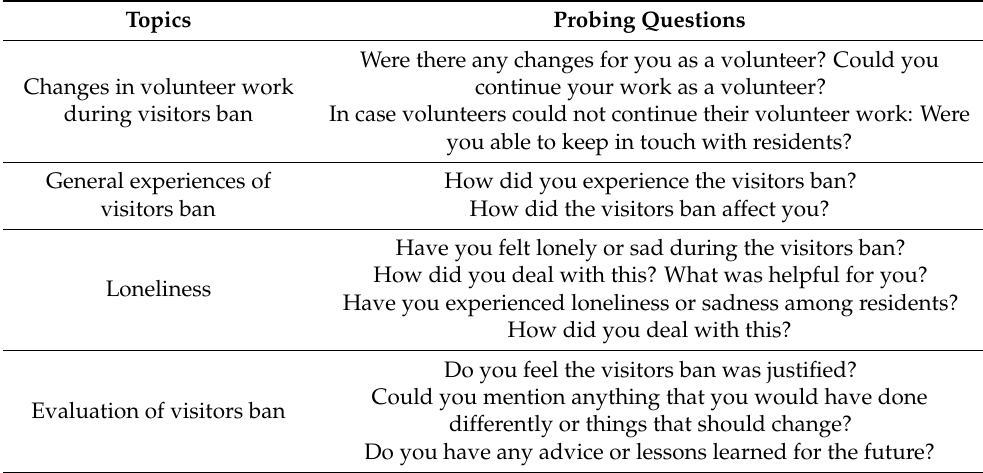
Table A2. Semi-structured interview guide for focus group with volunteers.